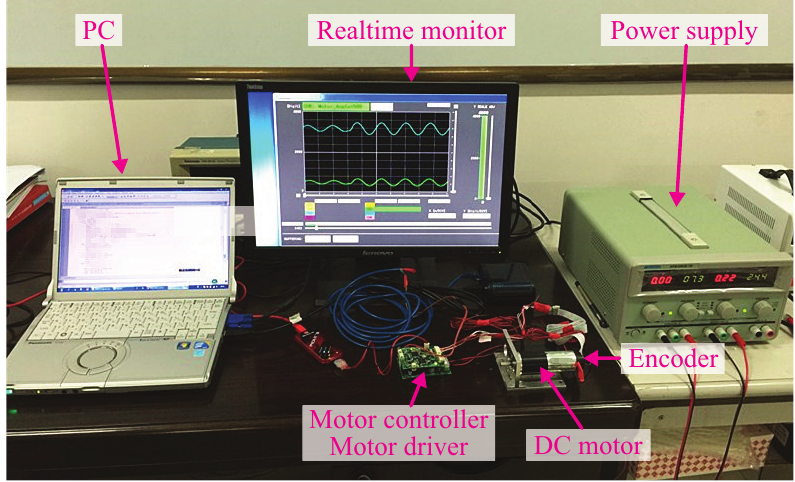
Figure 11. Experimental